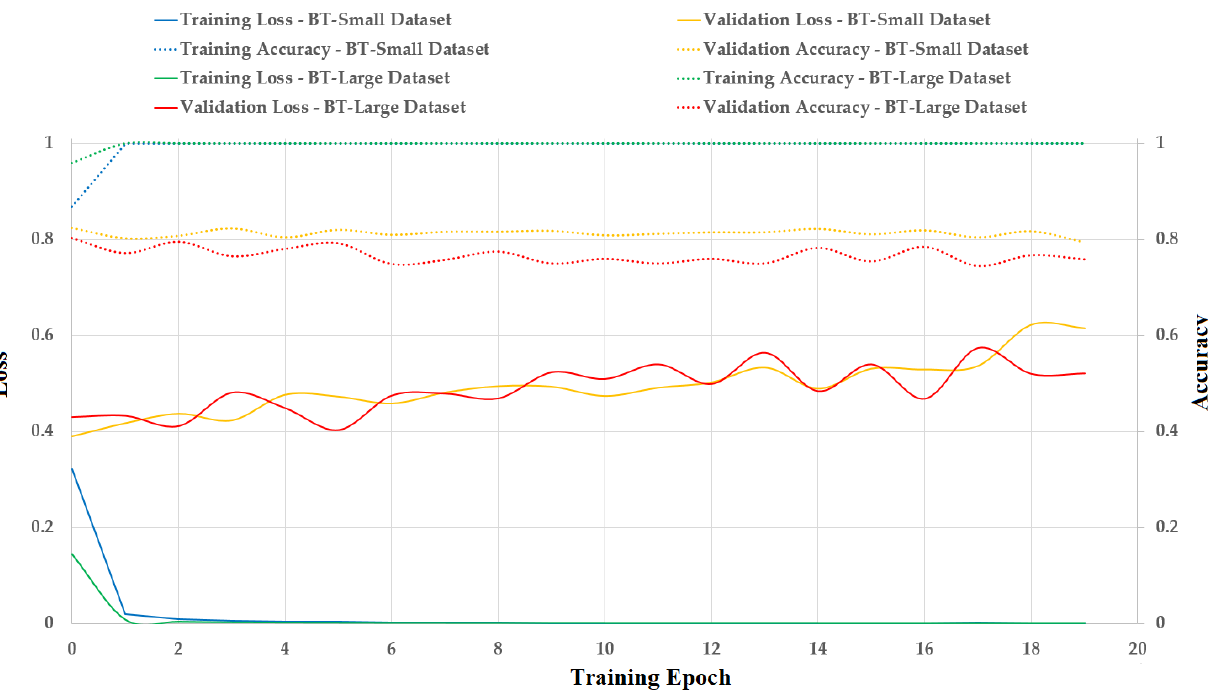
Figure 10. Training and validation curves (loss and accuracy) of the FS network with the BT-Small and BT-Large datasets.